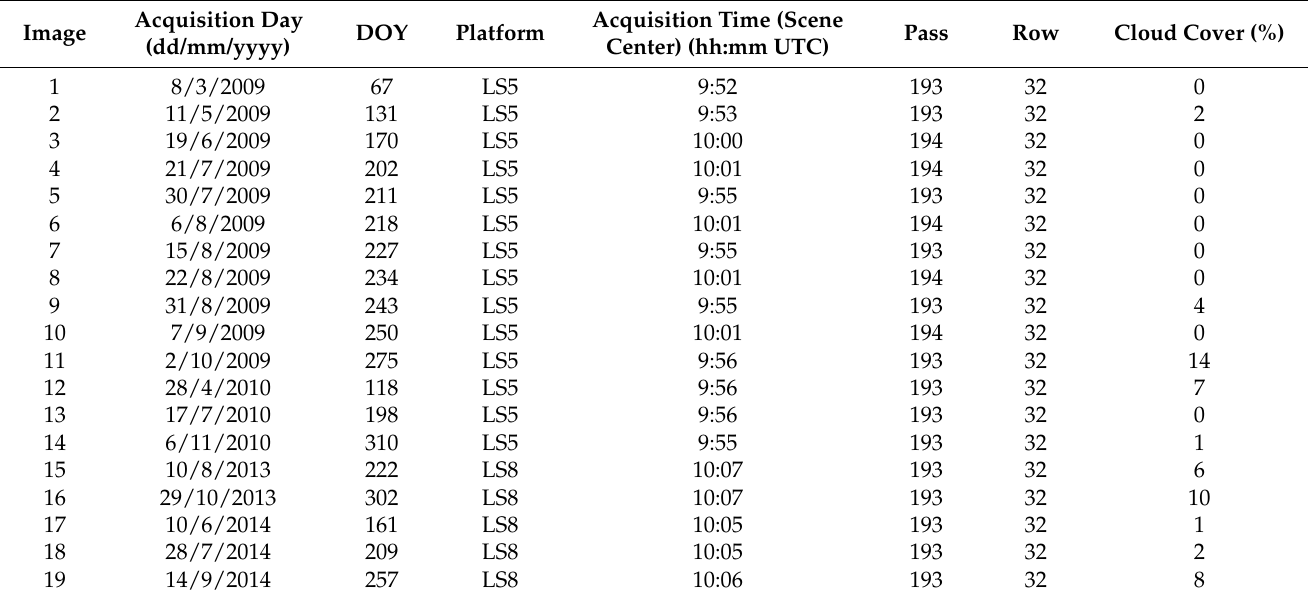
Table 1. Selected Landsat 5 (LS5) and Landsat 8 (LS8)